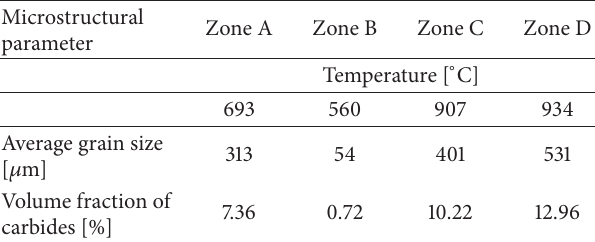
Table2:Quantitativemicrostructureindifferentzonesofthenozzle